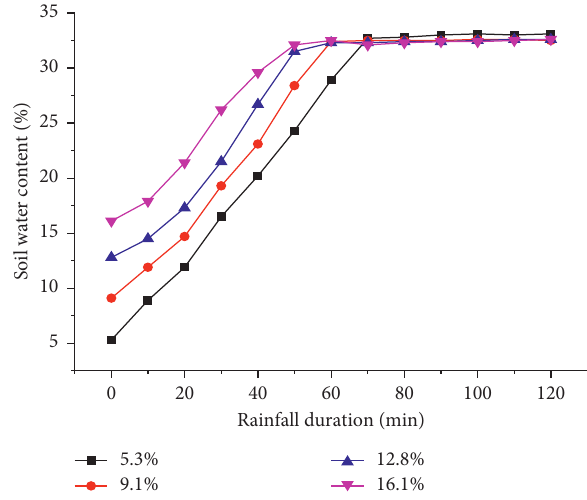
Figure 16: Effect of initial water content at 200mm depth on